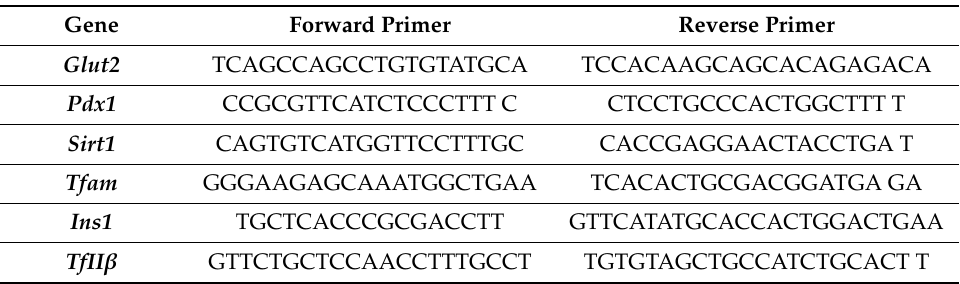
Table 1. The nucleotide sequences of the PCR primers used to assay gene expression by qPCR. Gene